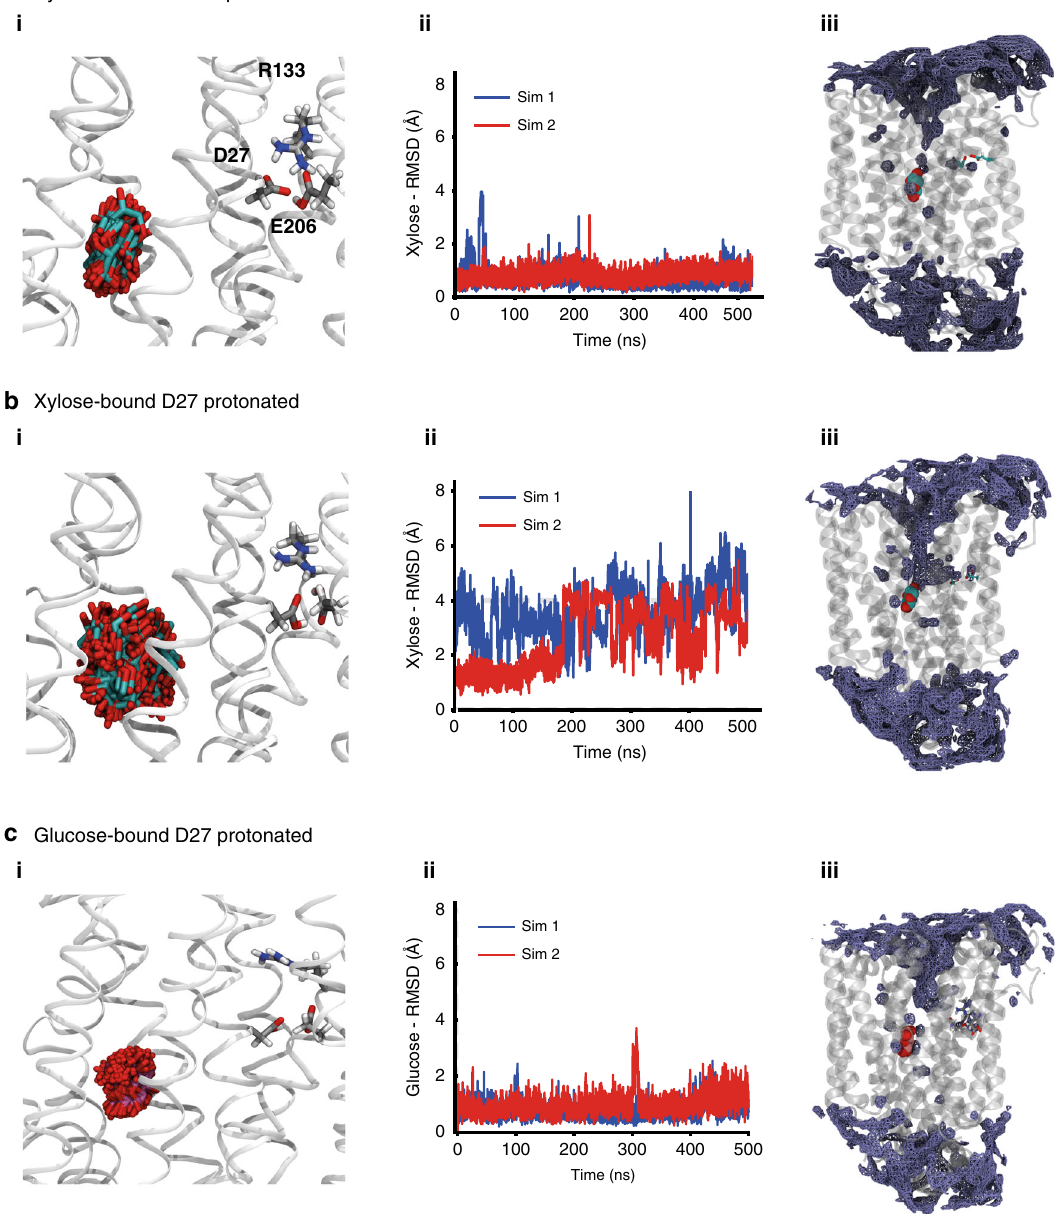
Fig. 5 Molecular dynamics simulations reveal differences in ligand stability and water accessibility. a (i, ii) MD simulations of xylose (shown in cyan and red sticks)-bound XylE (initiated from the crystal structure pose, PDB: 4GBY) in the D27-unprotonated state highlights that the bound substrate